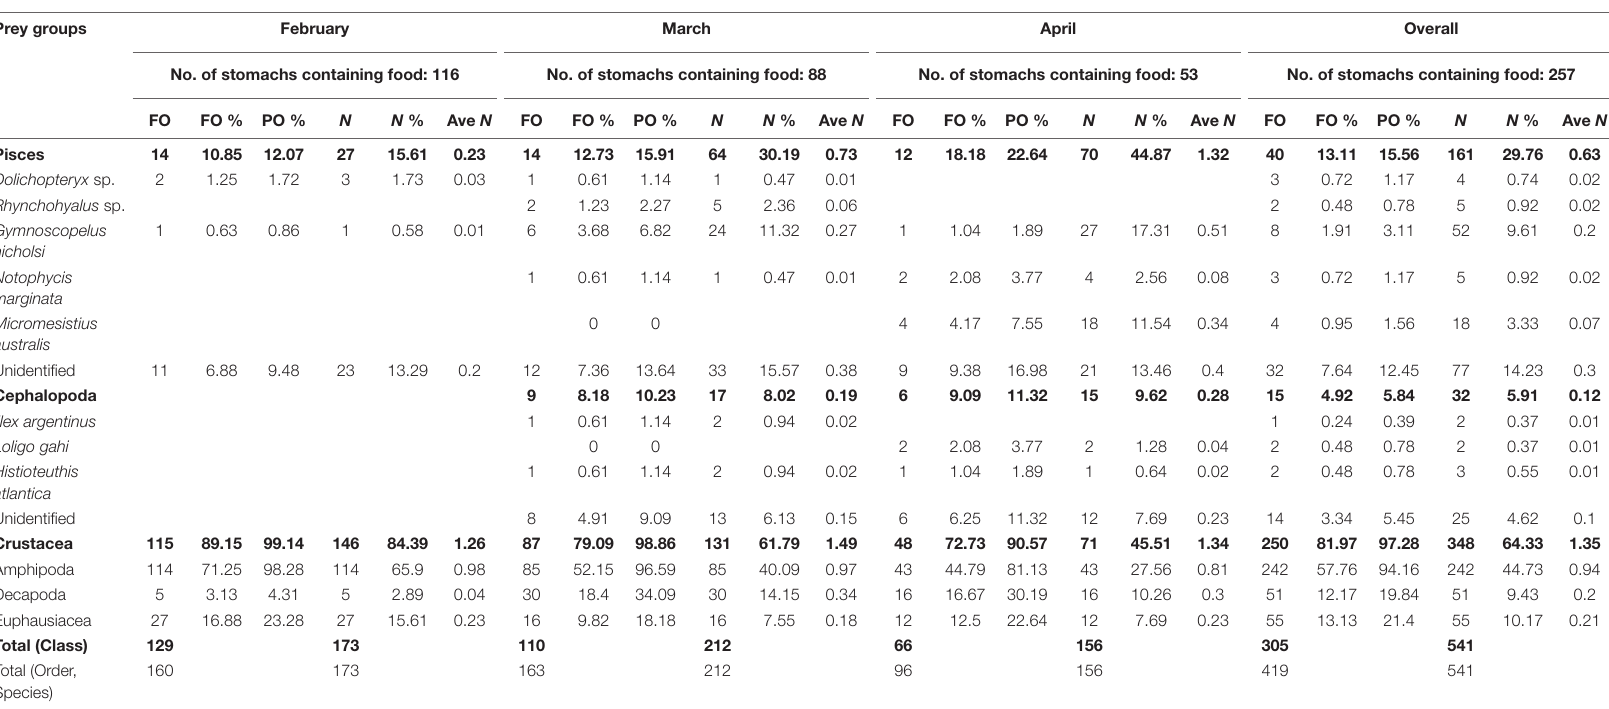
TABLE 2 | Dietary compositions of prey taxonomic groups, identified to the lowest possible taxonomic levels, from the stomach content analysis of Argentine shortfin squid Illex argentinus in the Southwest Atlantic. Prey